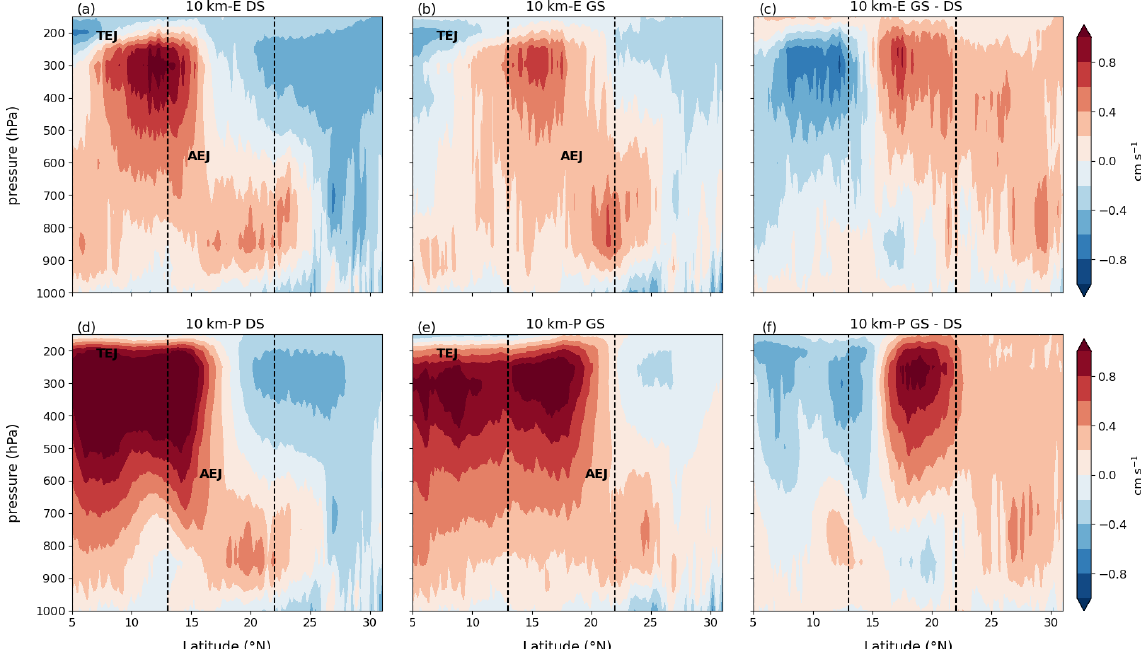
Figure B3. Vertical cross section of the vertical wind component for the 10km-E DS (a) , GS (b) , and the difference between the GS and DS (c) simulation; similarly for the 10km-P DS (d) , GS (e) , and GS minus DS (f) simulation, respectively. We averaged over the WA domain outlined in Fig. 1. Again, the locations of the African easterly jet (AEJ) and the tropical easterly jet (TEJ) are indicated by the labels. The dashed vertical lines again indicate the latitudes of the coastal, Sahel, and Sahara domain also displayed in Fig. 1.